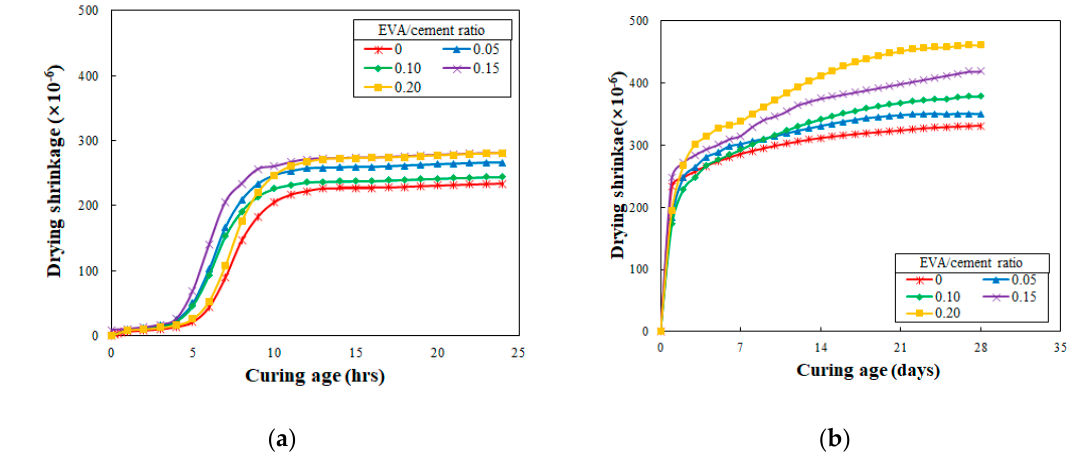
Figure 11. Drying shrinkages for different EVA/cement ratios at ( a ) 24 h and ( b ) 28 days.